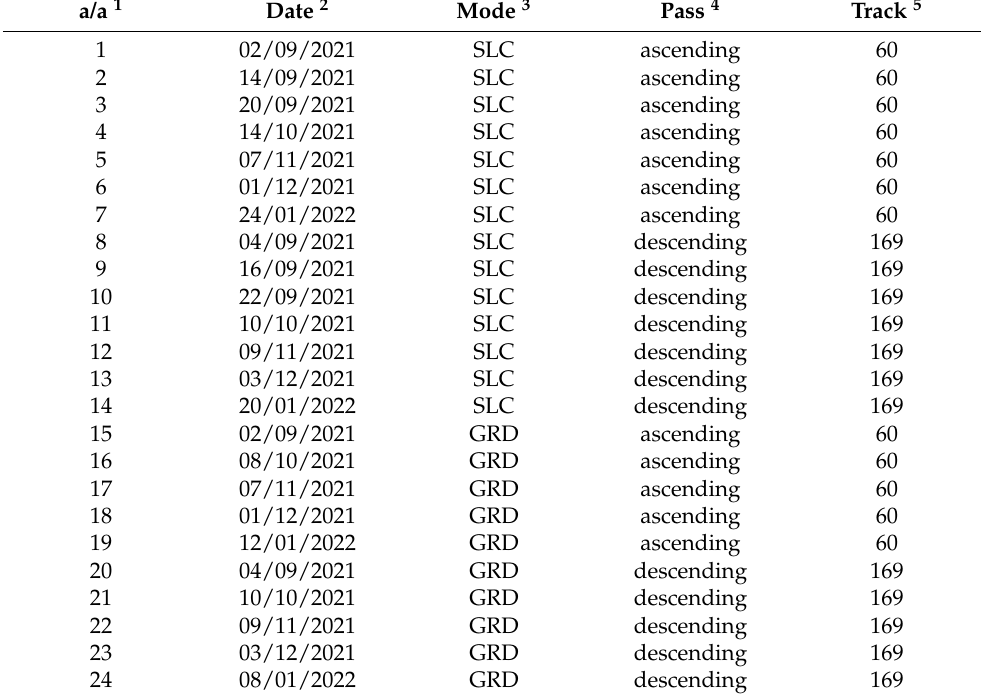
the satellite moves southwards across the Earth. 5 Relative orbit of Sentinel-1 acquisitions.